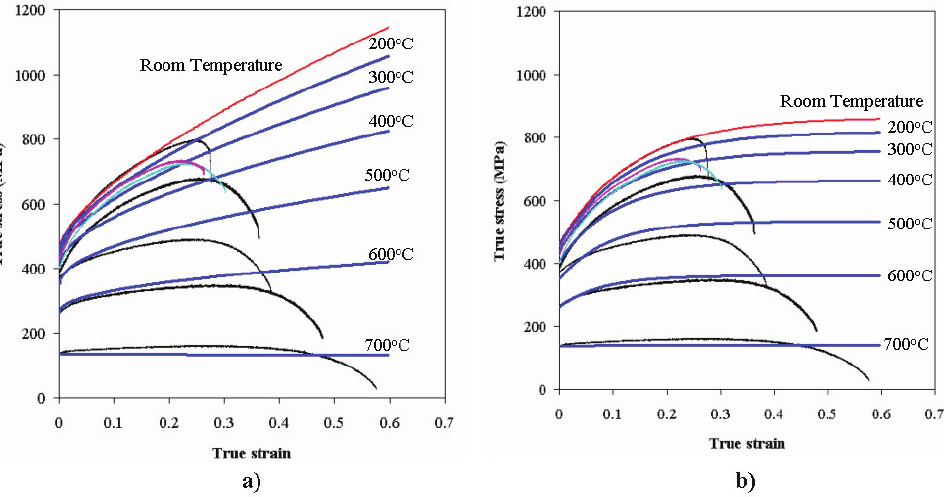
Figure 8. New prediction of modified J-C model at elevated temperatures with (a) Ludwick’s and (b) Voce’s hardening law.